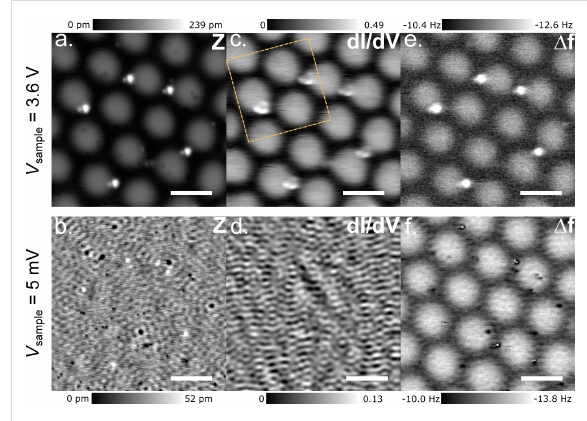
Figure 2: STM/AFM characterisation of a h -BN/Cu(111) Moiré super- structure. (a., b.) Constant-current topography at I = 500 pA and V = 3.6 V (top) or V = 5 mV (bottom). (c., d.) Simultaneously measured differential conductance (d I /d V ) maps ( V mod = 10 mV (top) and V mod = 1 mV (bottom). (e., f.) Frequency shift ( Δ f ) maps ( A osc = 50 pm). The dashed yellow box marks the area used for the Φ maps in Figure 3 (see below). Scale bar: 10